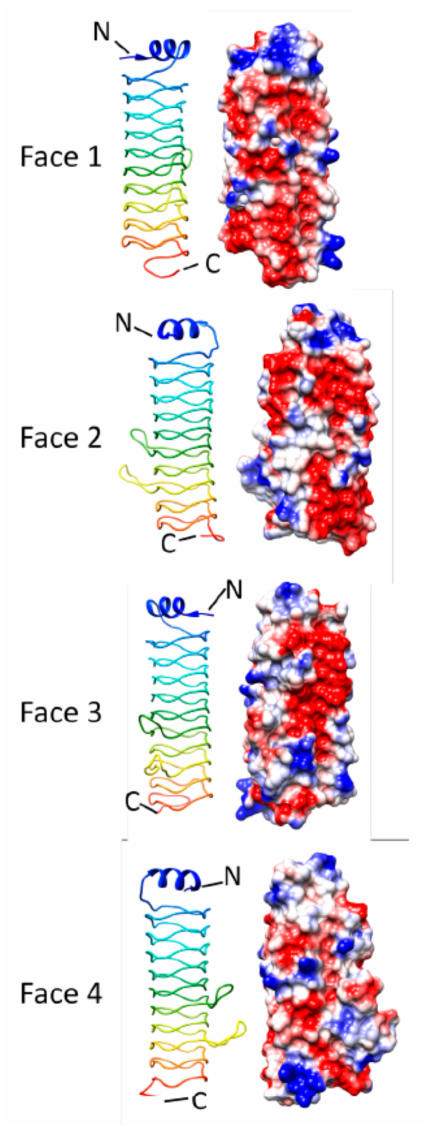
Figure 13. Structure and analysis of HetL. Ribbon diagrams of the structure (PDB ID: 3DU1) for four different orientations (at left) and the corresponding electronic potential surface plots (at